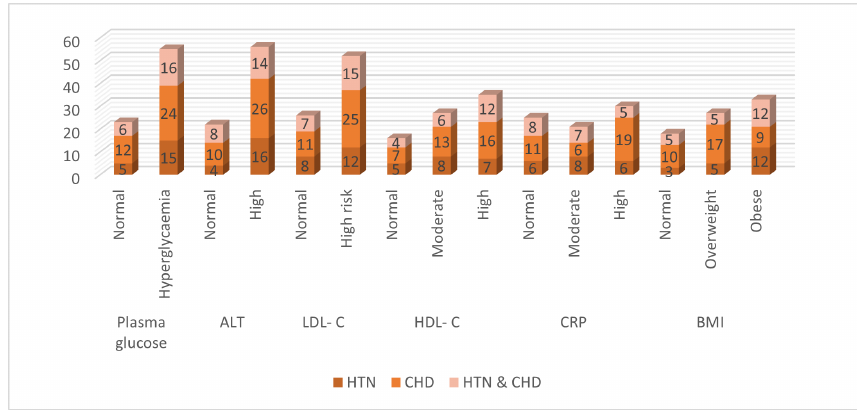
Figure 1. Graphic representation of the effect of ICT Solutions on total anthropogepainic GHG